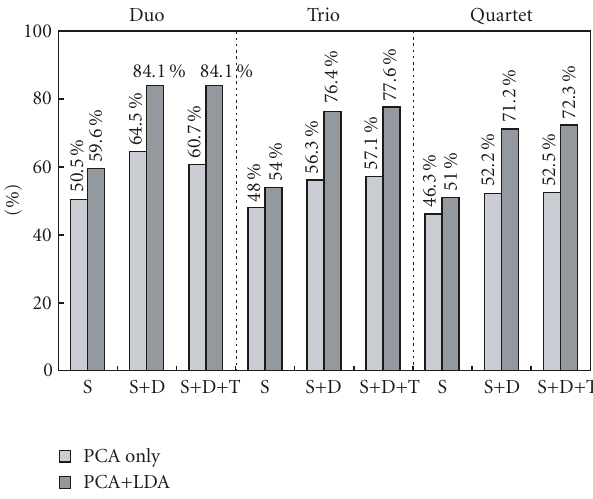
Figure 6: Comparison between using both PCA and LDA with us- ing only PCA (Experiment 4). “Duo,” “trio,” and “quartet” represent pieces for test (identification). “S,” “S+D,” and “S+D+T” represent types of templates.